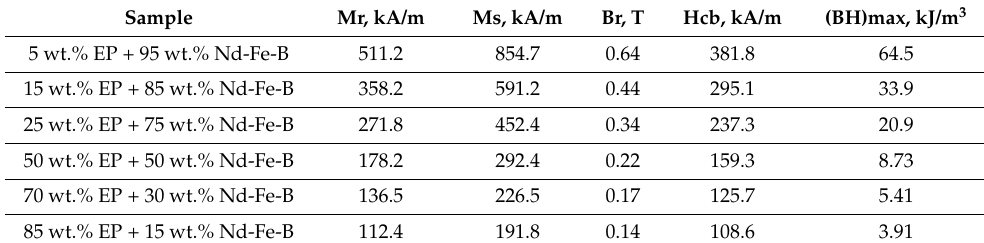
Table 1. Summary overview of the magnetic parameters of the composites. Sample